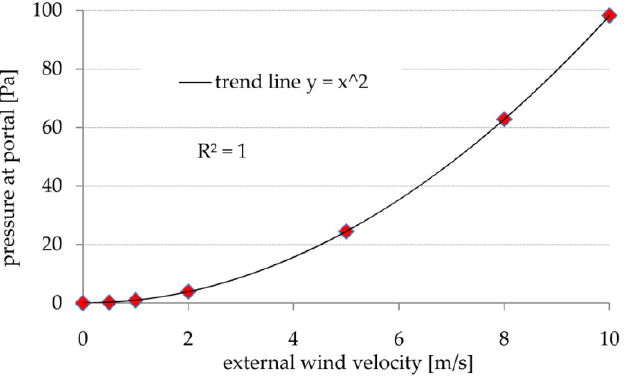
Figure 9. Additional pressure at the portal due to the external wind.